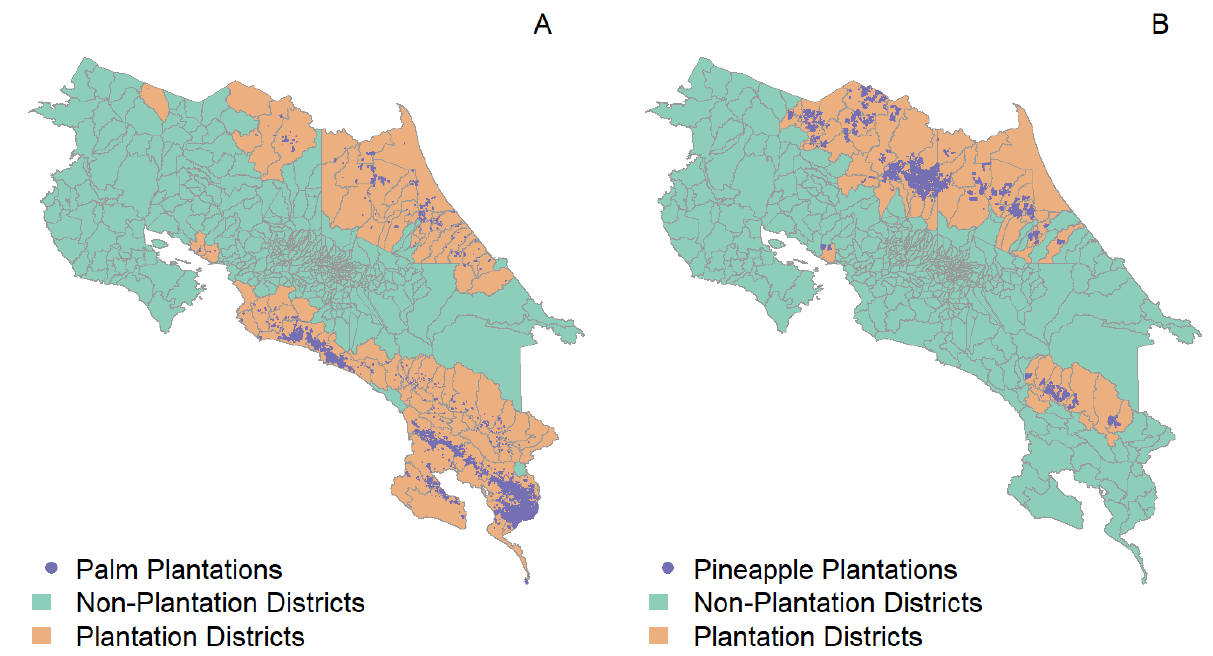
Figure 2. Major plantation landscapes of Costa Rica for ( A ) oil palm and ( B ) pineapple. In both panels, the inset legends indicate the location of the plantations, and districts are colored according to the presence of plantations. Estimates are for 2019 and based on estimates from the PRIAS lab at the Centro Nacional de Alta Tecnología, CENAT [78,79].